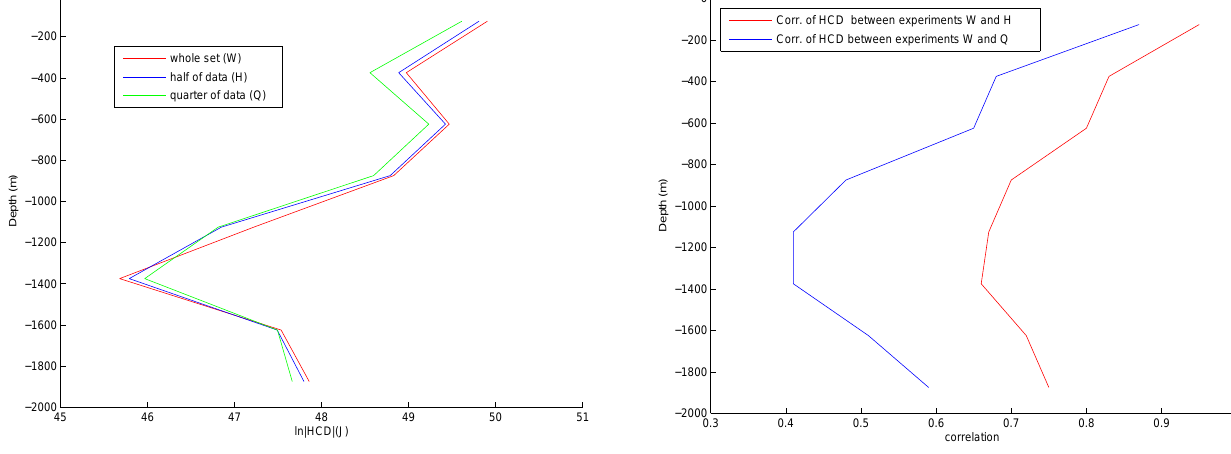
Fig. 5. Correlations between HCD for the whole set and 50% of data (red curve) and between whole set and 25% of data (blue curve). HCD is the averaged value of the North Atlantic, the verti- cal discretisation is